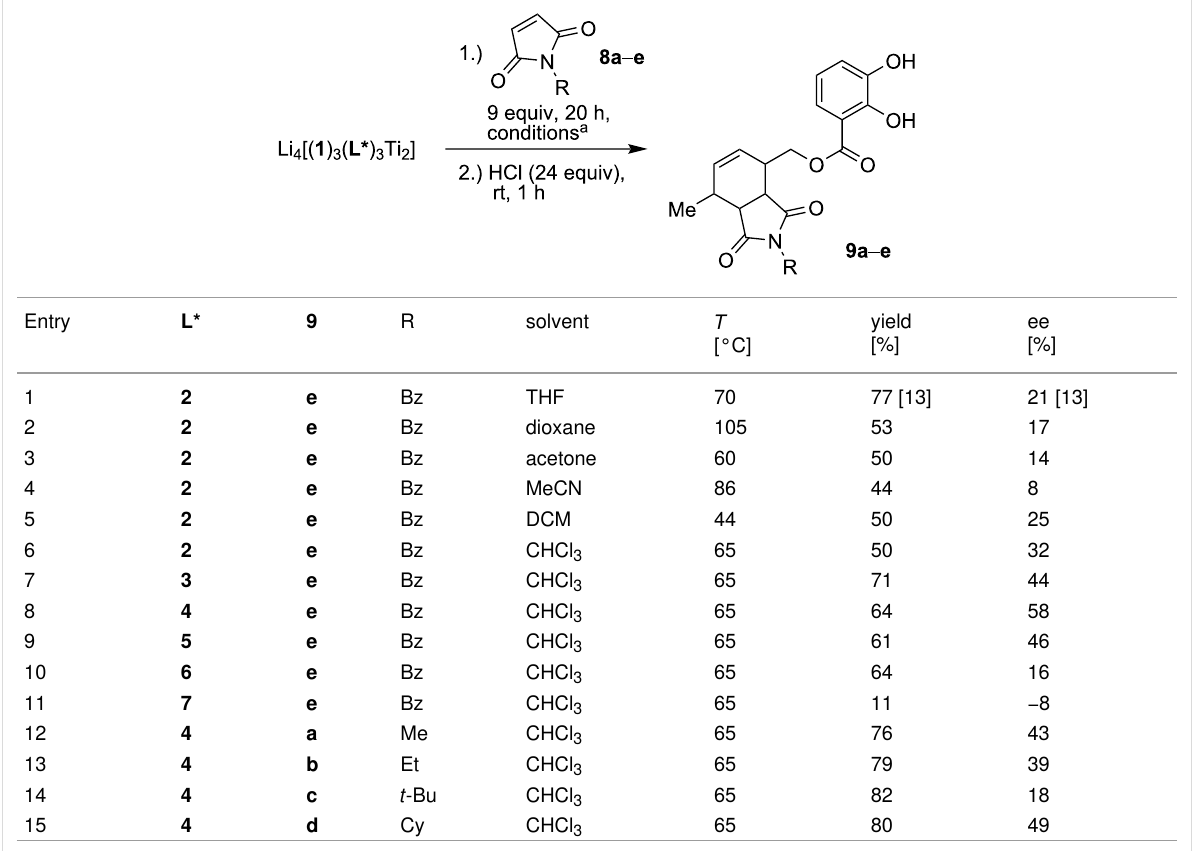
a Reactions performed in closed